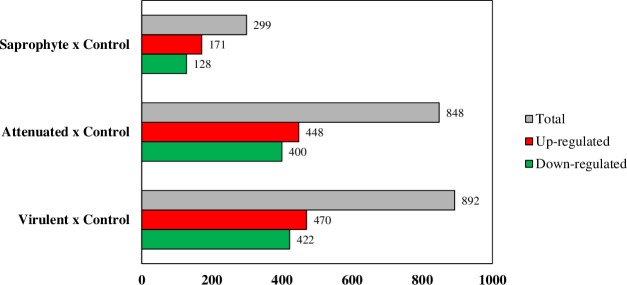
Differentially expressed genes after 6 hours of infection in murine macrophages J774A.1 with saprophytic, attenuated and virulent strains of Leptospira spp.The colored bars show the up-regulated (red) or down-regulated (green) genes and grey a total of genes. (n = 3 / assay, FDR-adjusted p<0.05, fold change ± 2).